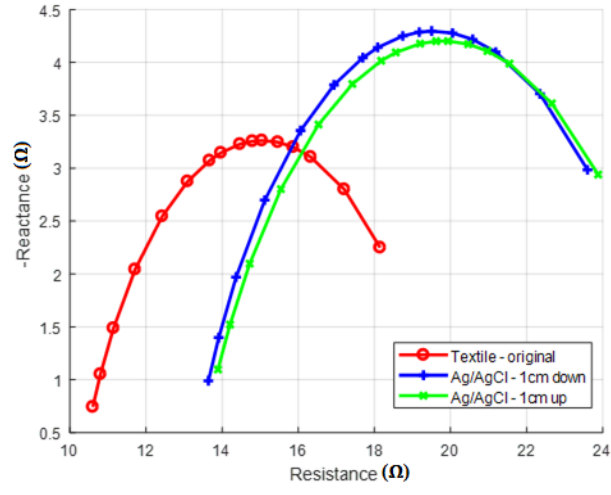
Figure 9. Results moving the Ag/AgCl electrodes.